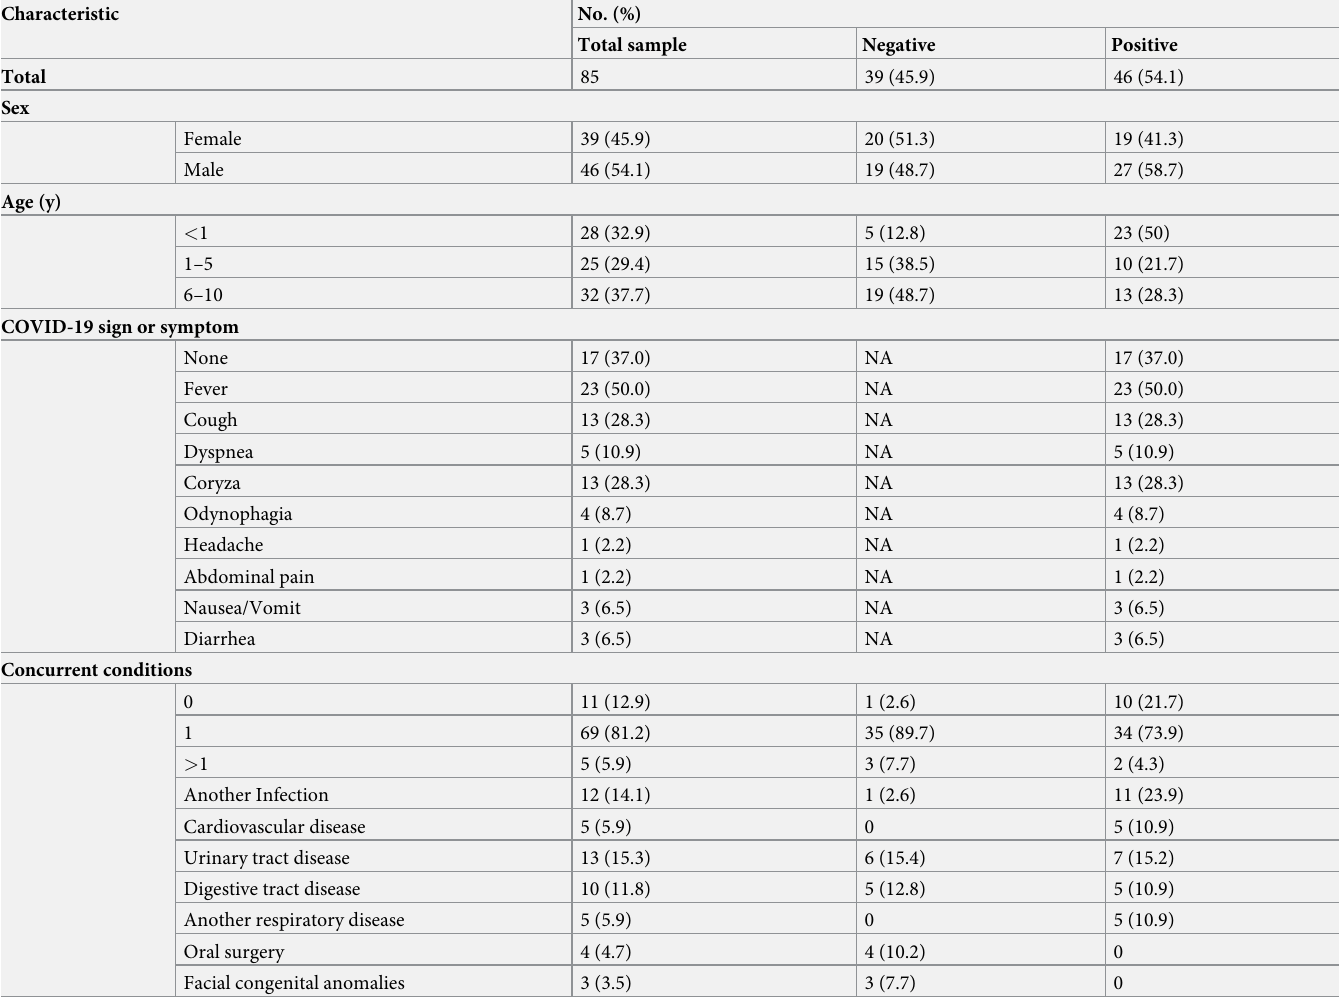
Table 2. Characteristics and reported signs and symptoms of SARS-CoV-2-positive and negative children included in this study.